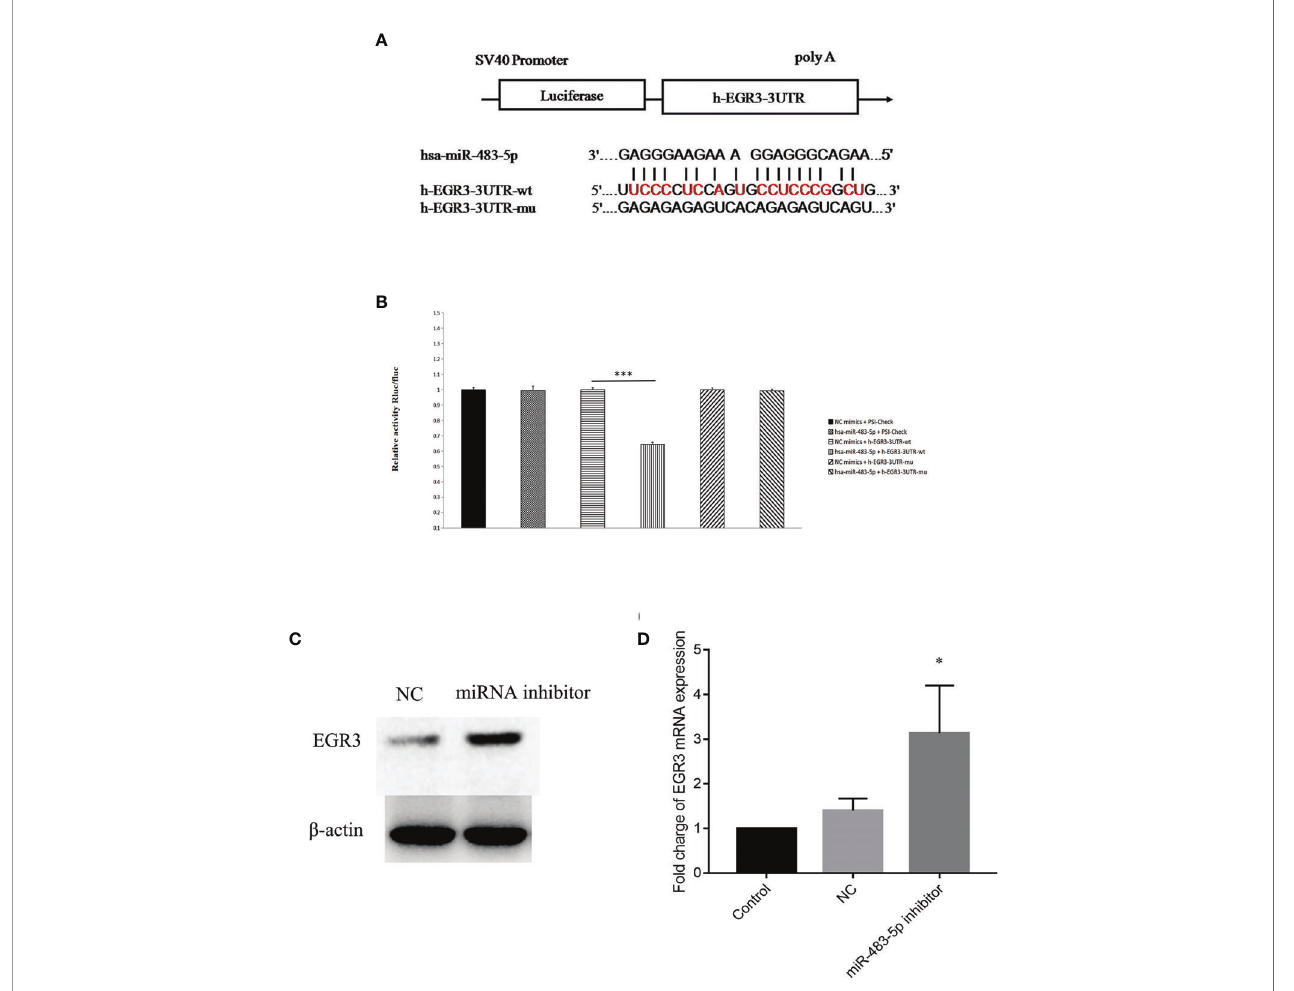
FIGURE 3 | EGR3 was a direct target of miR-483-5p in nasopharyngeal carcinoma (NPC) cell lines. (A) Wild-type (Wt) or mutant (Mt) target sequences of the EGR3 mRNA 3 ′ -UTR. (B) The luciferase reporter assay was performed in 5-8F cells transfected with the psiCHECK luciferase reporter plasmid containing the Wt 3 ′ -UTR of EGR3 , Mt 3 ′ -UTR of EGR3 , a miR-483-5p mimic, and the negative control. (C) Western blot assay of the protein level of EGR3 in 5-8F cells after transfection with the miR-483-5p inhibitor. (D) Relative quanti fi cation of the mRNA expression of EGR3 by quantitative RT-PCR in 5-8F cells after transfection with the miR-483-5p inhibitor.* p < 0.05, *** p <